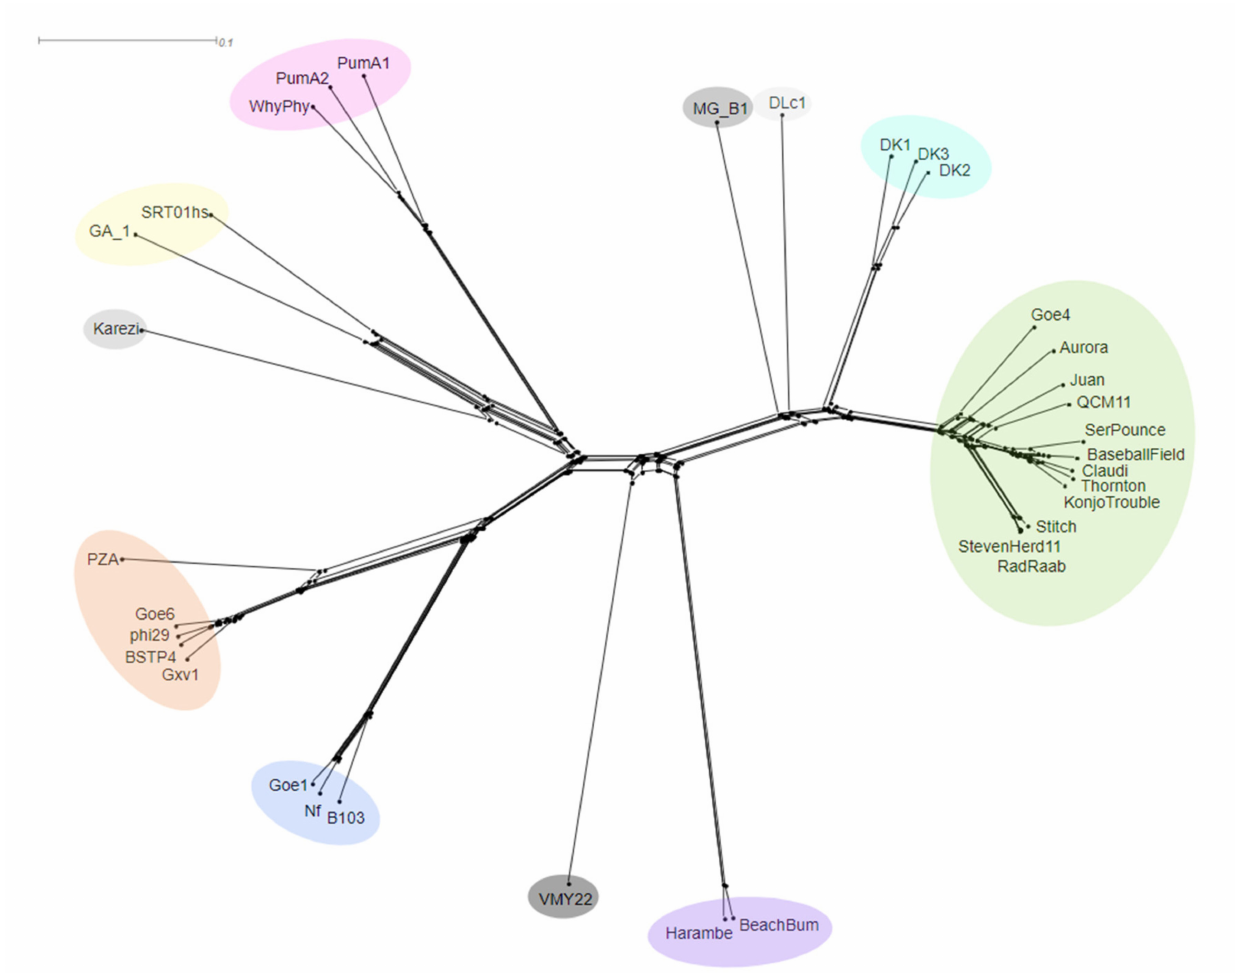
Figure 5. Neighbor-Joining network of the phi29-like phages. Clustal Omega alignments of the whole genomes were calculated and visualized in Splitstree. Clusters are displayed by corresponding colored